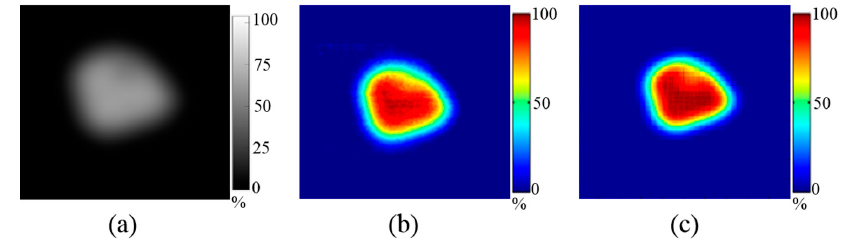
Figure 5. An example of measured 2D dose distribution using various dosimetric tools for the irregular-shaped field. (Field 4 in Table 2) ( a ) MatriXX; ( b ) EBT3 film; ( c ) FORS. Table 2. Mean passing rates in gamma indices based on the gamma evaluation method for irregularly-shaped fields using MatriXX, EBT3 film, and FORS (units: %).